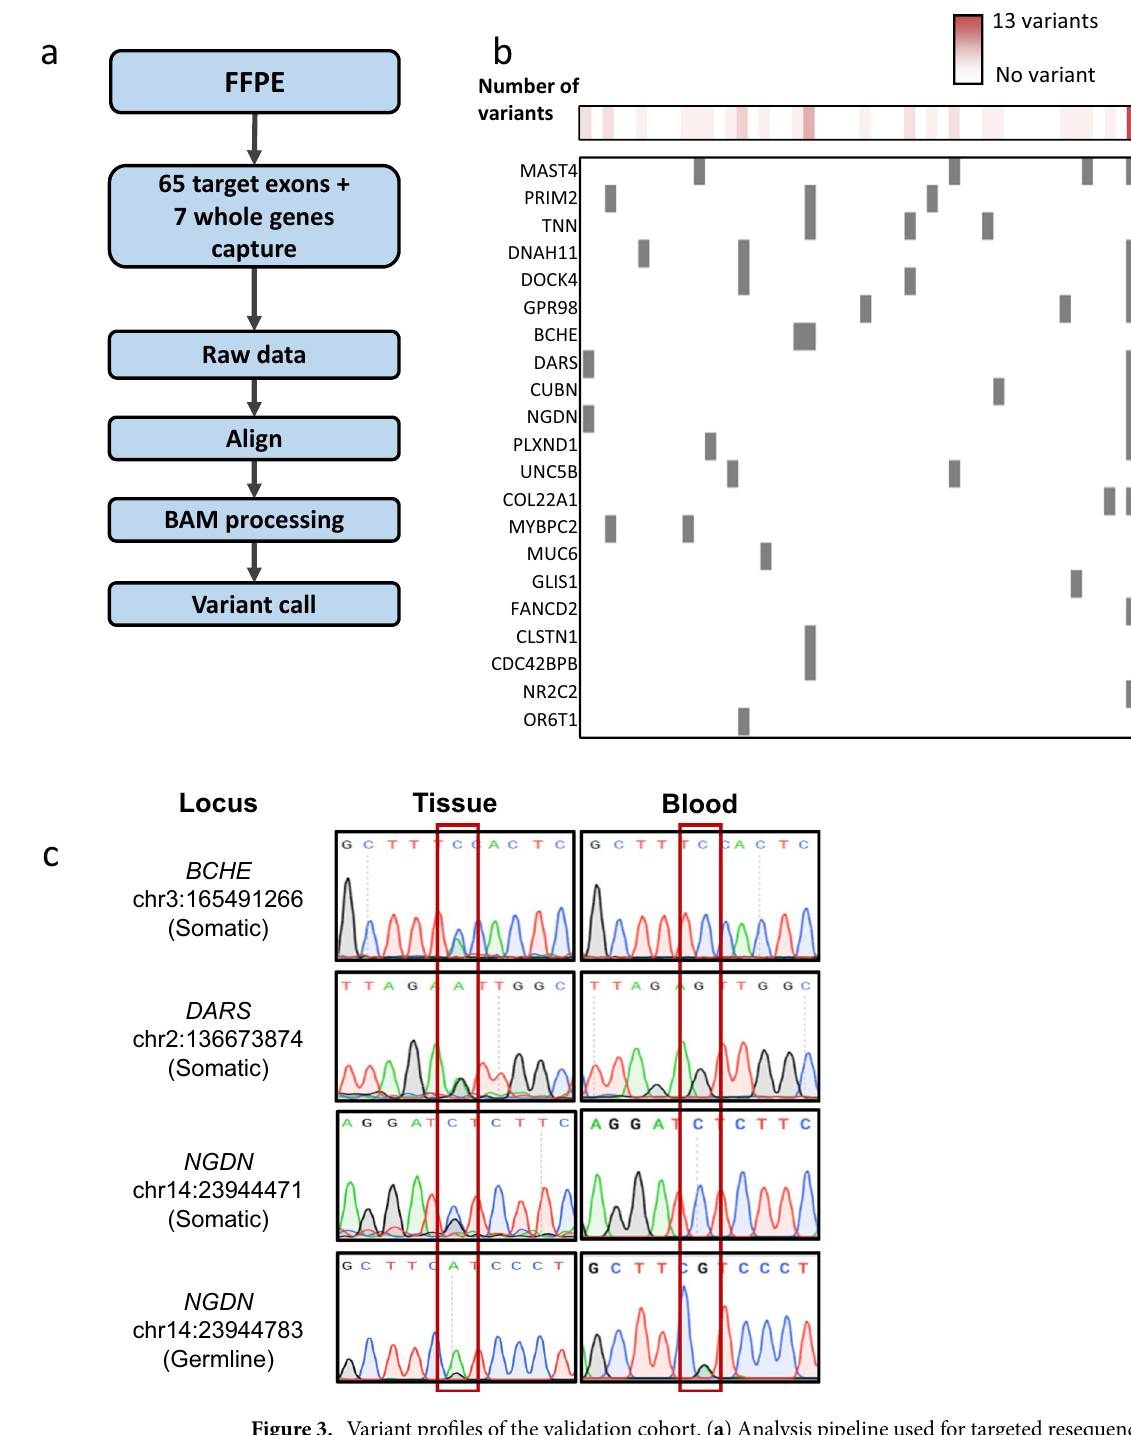
Figure 3. Variant profiles of the validation cohort. ( a ) Analysis pipeline used for targeted resequencing data (drawn in Microsoft 365 Powerpoint). ( b ) Variant profiles of validation cohort. Genes were sorted in descending order of frequency (created in Microsoft 365 Excel). ( c ) Representative images of Sanger sequencing of DARS , BCHE , and NGDN . Left and right panels represent the genotype of the tissue and blood, respectively (created in Snap Gene Viewer; https:// www. snapg ene. com/ snapg ene-